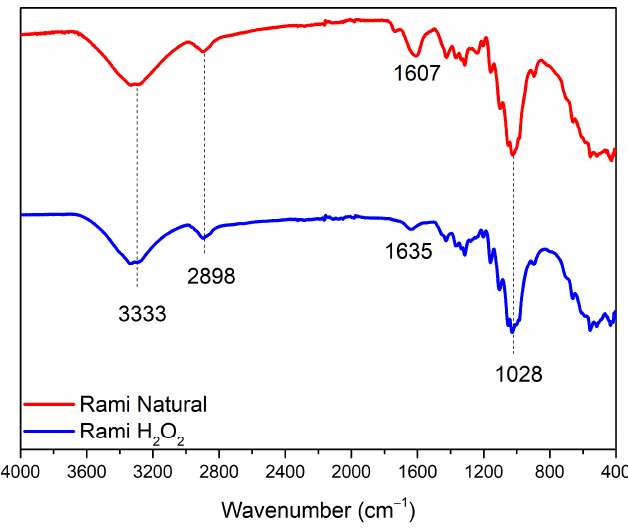
Figure 7. Typical FTIR spectra of different types of ramie fiber.